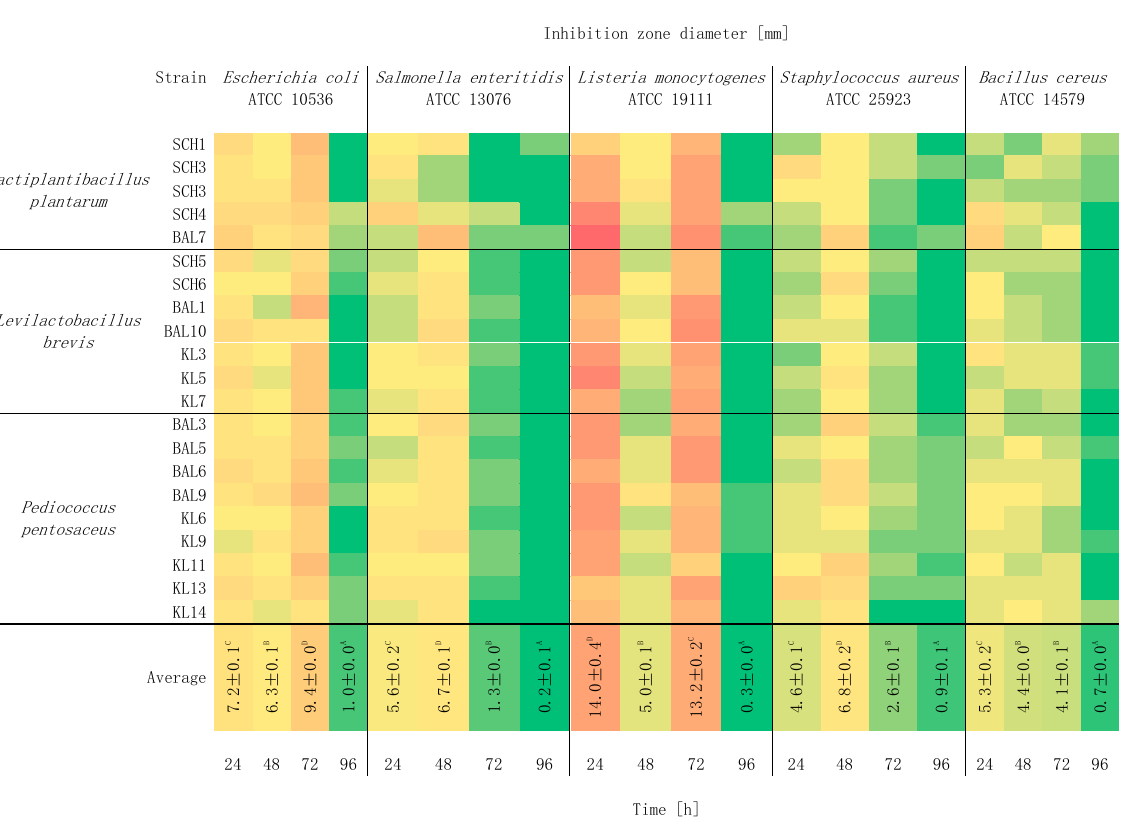
Figure 1. Heatmap about the influence of incubation time on the antimicrobial activity of LAB strains and against indicator bacteria ( n = 3). Means in the same column followed by different letters (A–D) represent significant differences ( p < 0.05) for each incubation time and indicator bacteria.